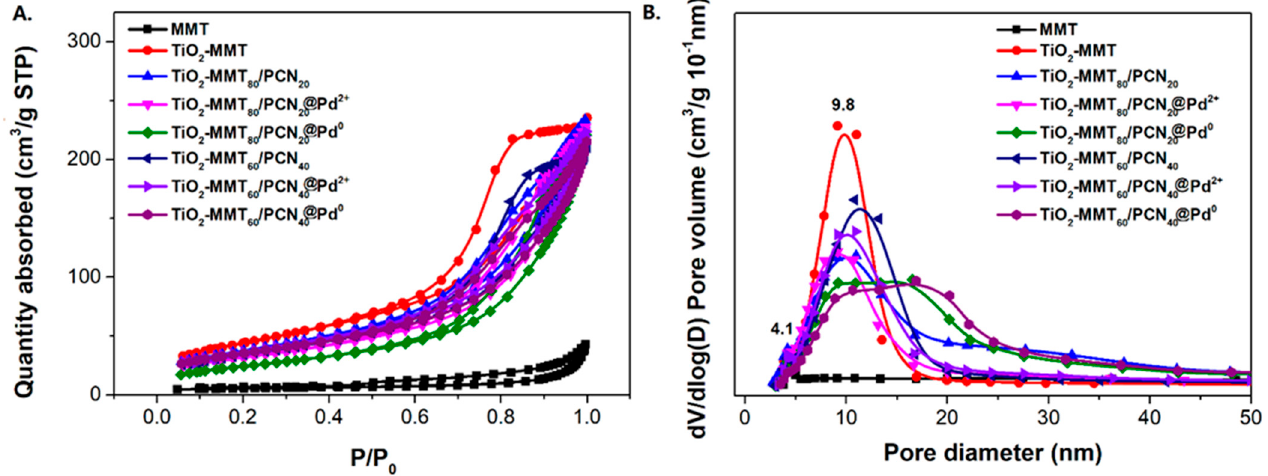
Figure 5. N 2 adsorption/desorption isotherms ( A ) and corresponding pore size distribution ( B ) of the TiO 2 -MMT/PCN@Pd nanocomposites. Table 1. Structural parameters of TiO 2 -MMT/PCN@Pd nanocomposites extracted from the iso- therms in Figure 5.